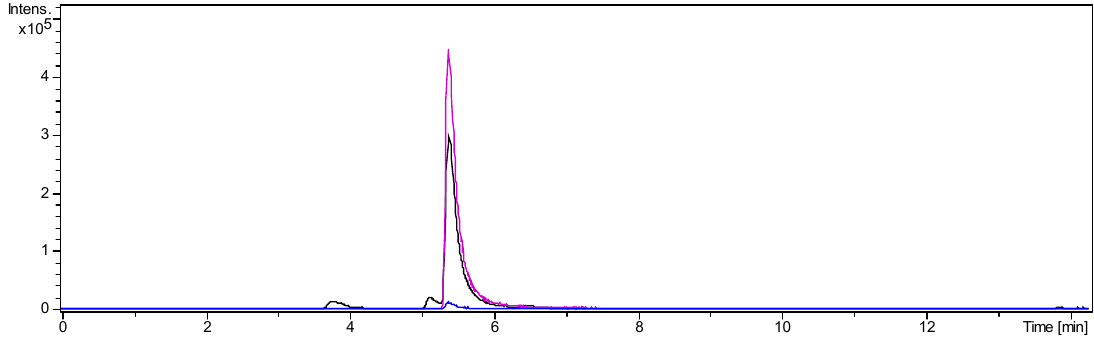
Figure 3. UHPLC/+ESI-QqTOF-MS chromatogram of O -tigloylcyclovirobuxeine-B ( 1 ): Base peak chromatogram of m/z 200–1000 (black), Extracted ion chromatogram of m/z 249 [M + 2H] 2+ (pink), Extracted ion chromatogram of m/z 497 [M + H] + (blue). Enrichment of 1 from fraction 2 was 7.8-fold.